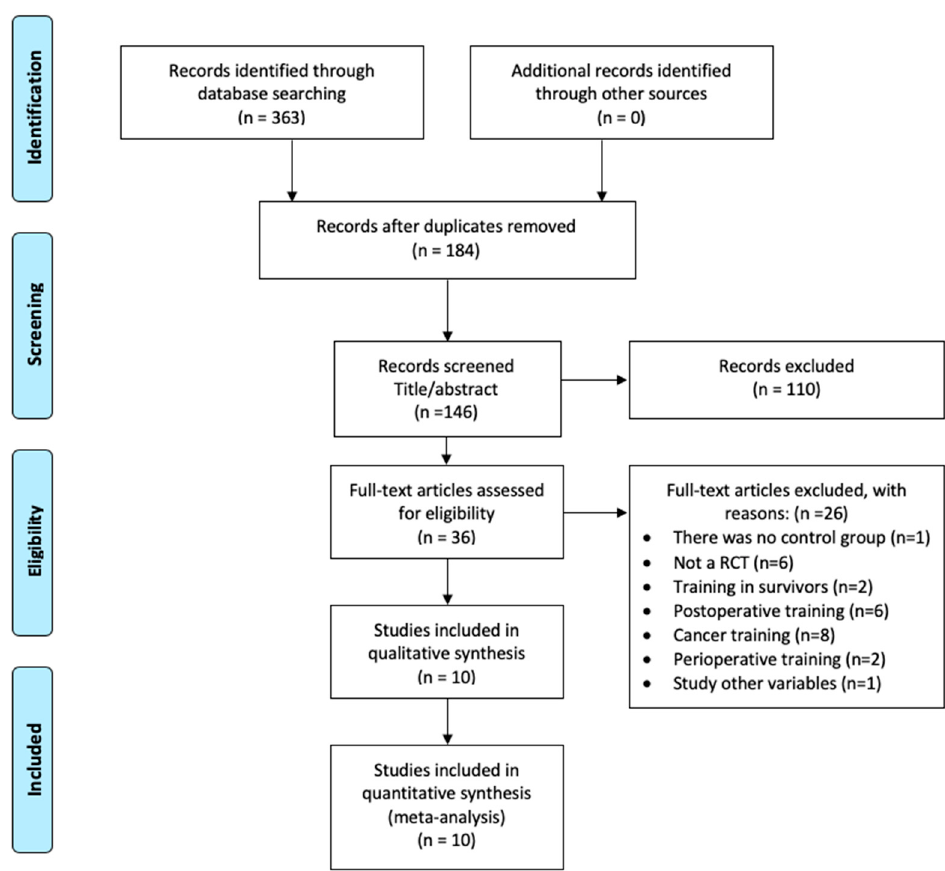
Figure 1. Preferred Reporting Items for Systematic Reviews and Meta-Analysis (PRISMA) flow diagram showing the number of studies identified and selected for inclusion in the systematic scoping review .